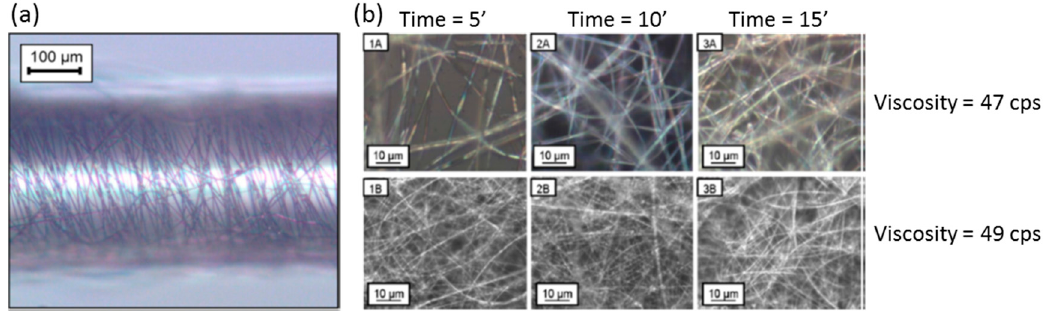
Figure 39. ( a ) Microscope image of an optical fibre core coated with the PAA electrospun fibres; ( b ) SEM images for the nano webs obtained with the different electrospun conditions (detailed inset). Reprinted from [37] with the permission of Elsevier.